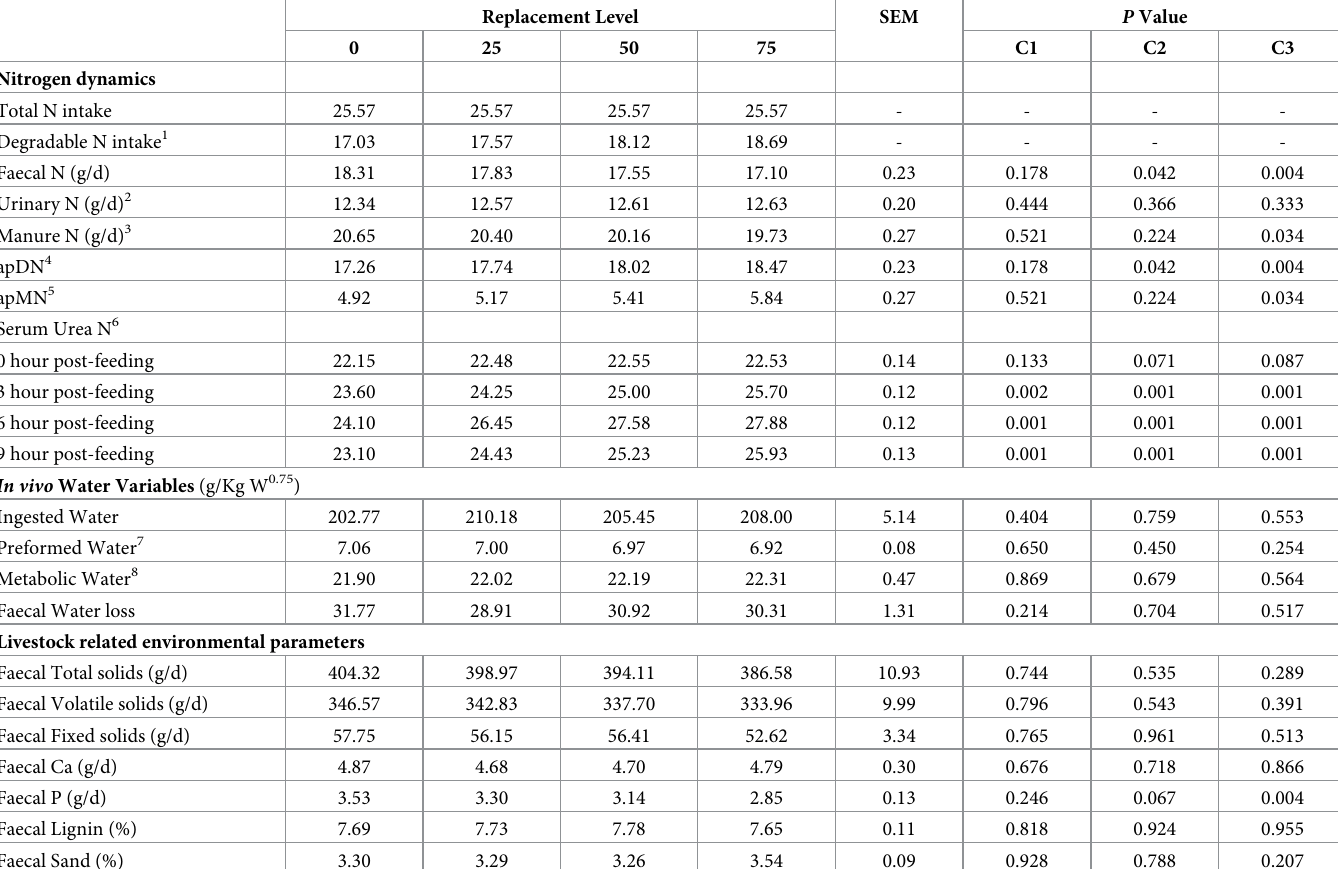
Table 5. Effect of replacing soybean meal with SRU on Nitrogen dynamics and water balance of adult rams. Replacement